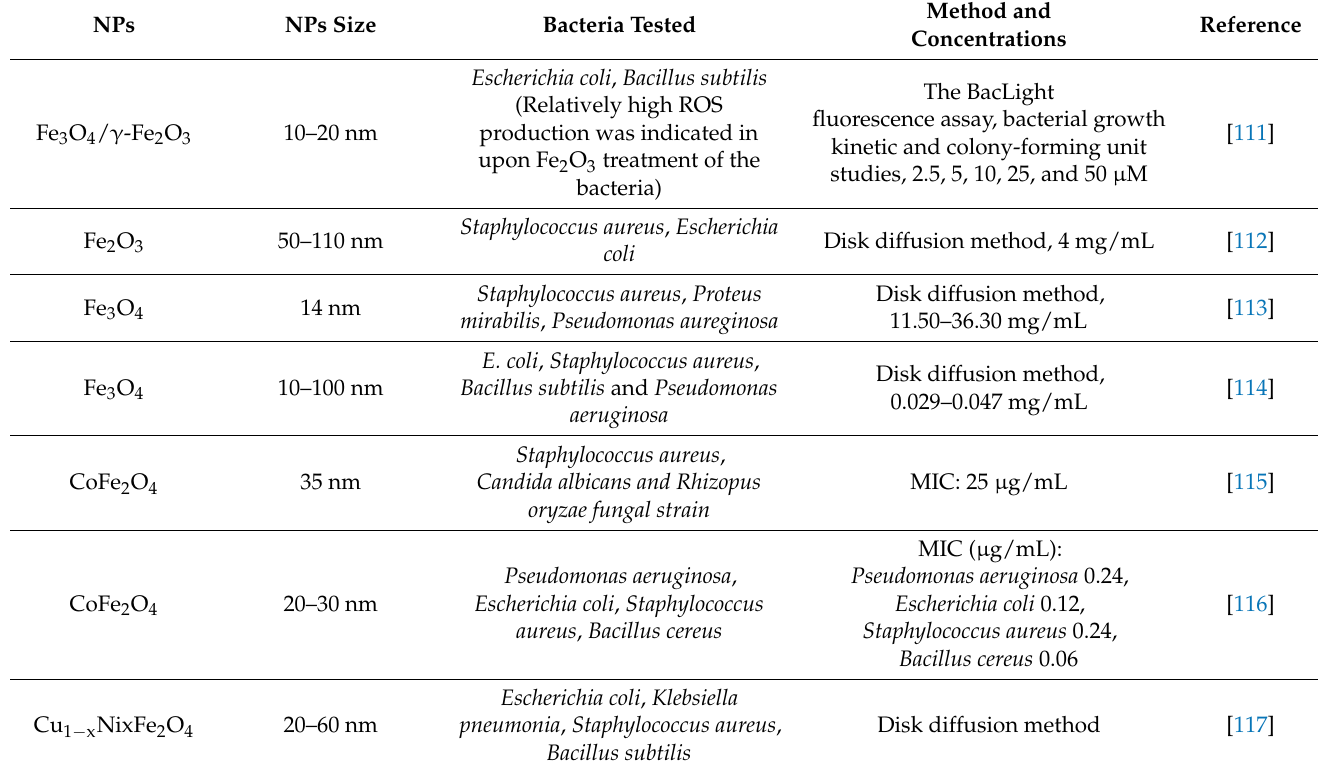
Table 2. Antibacterial activity of magnetic NPs against bacteria